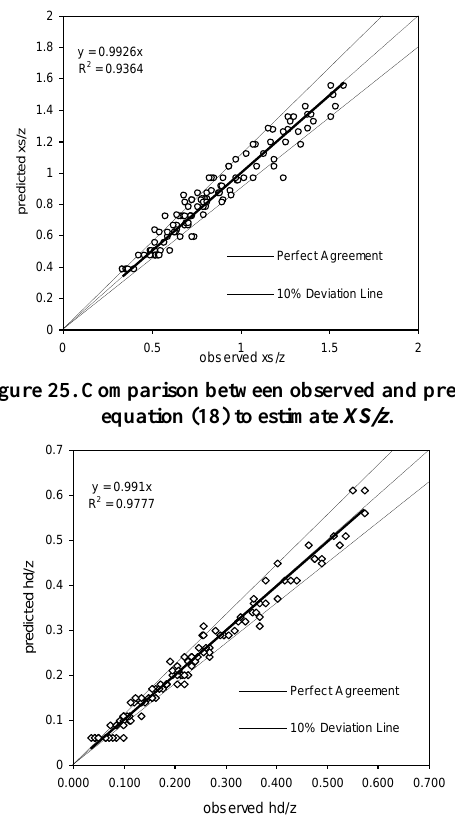
Figure 26. Comparison between observed and predicted equation (19) to estimate h d /z . y = 0.9979x R 2 = 0.9877